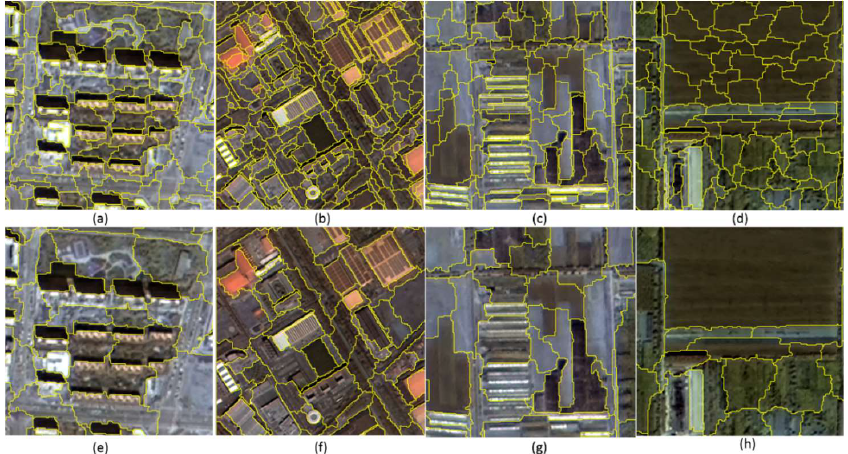
Figure 5. Subsets of segmenting four study areas: ( a–d ) are the segmentations of T1, T2, T3, and T4 produced by MRS with setting scale as 8, and ( e–h ) are the ones of T1, T2, T3, and T4 produced by MRS with setting scale as 20,